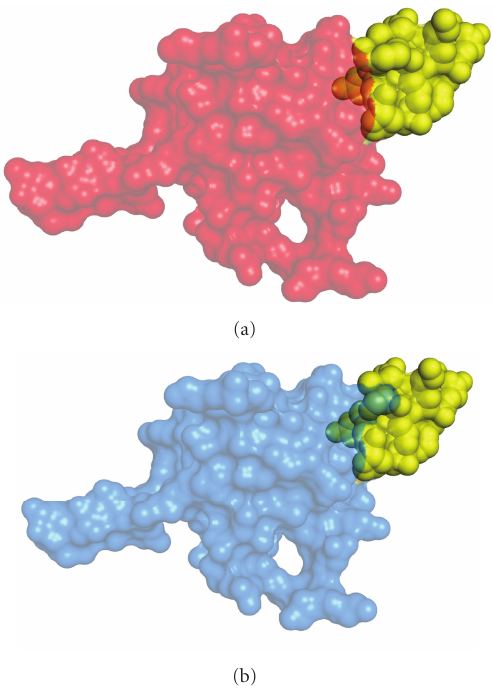
Figure 5: The experimental and predicted epitopes of 10 kDa chaperonin. The structural surfaces display the true epitopes (a) and predicted epitopes (b) in yellow spheres. The red and blue spheres represent the remainder of the protein. Both figures were created with